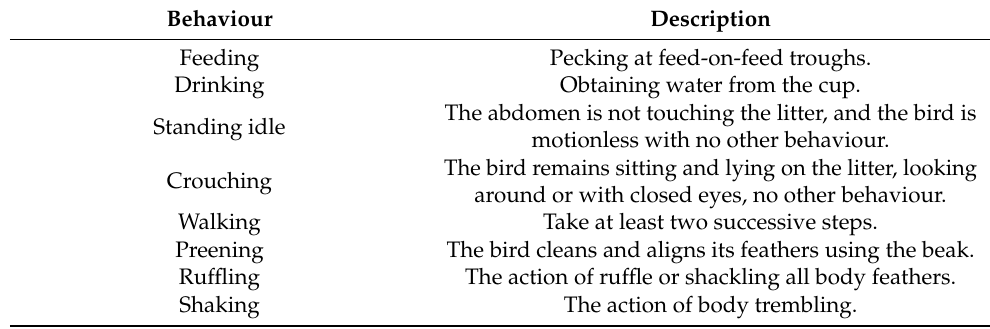
Table 2. Ethogram of the recorded behaviours. Behaviour Description Feeding Pecking at feed-on-feed troughs. Drinking Obtaining water from the cup. The abdomen is not touching the litter, and the bird is Standing idle motionless with no other behaviour. The bird remains sitting and lying on the litter, looking Crouching around or with closed eyes, no other behaviour. Walking Take at least two successive steps. Preening The bird cleans and aligns its feathers using the beak. Ruffling The action of ruffle or shackling all body feathers. Shaking The action of body